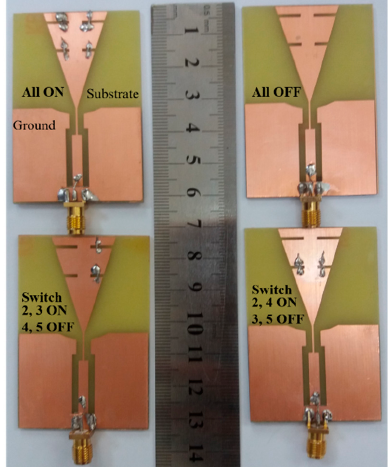
Figure 7. Fabricated prototype of the antenna showing different states.